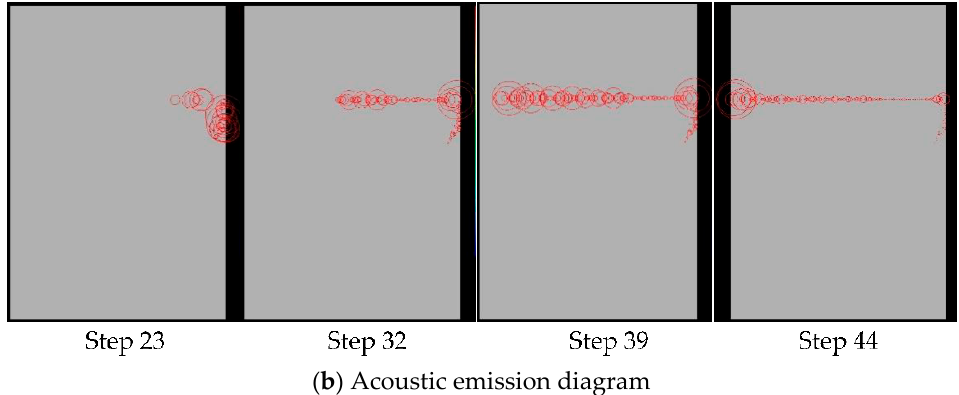
Figure 23. Failure process of specimens with concrete interface.